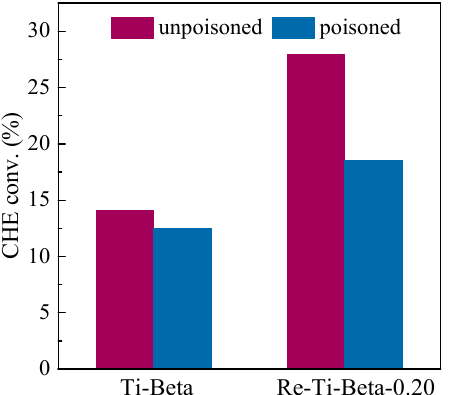
Figure 8. The catalytic performance of Ti − Beta and Re − Ti − Beta − 0.20 in the cyclohexene epoxidation reaction before and after selective poisoning. Reaction conditions: catalyst, 50 mg; CHE, 10 mmol; H 2 O 2 , 10 mmol; MeCN, 10 mL; TPhA, 2 mmol; temp., 333 K; time, 2 h.